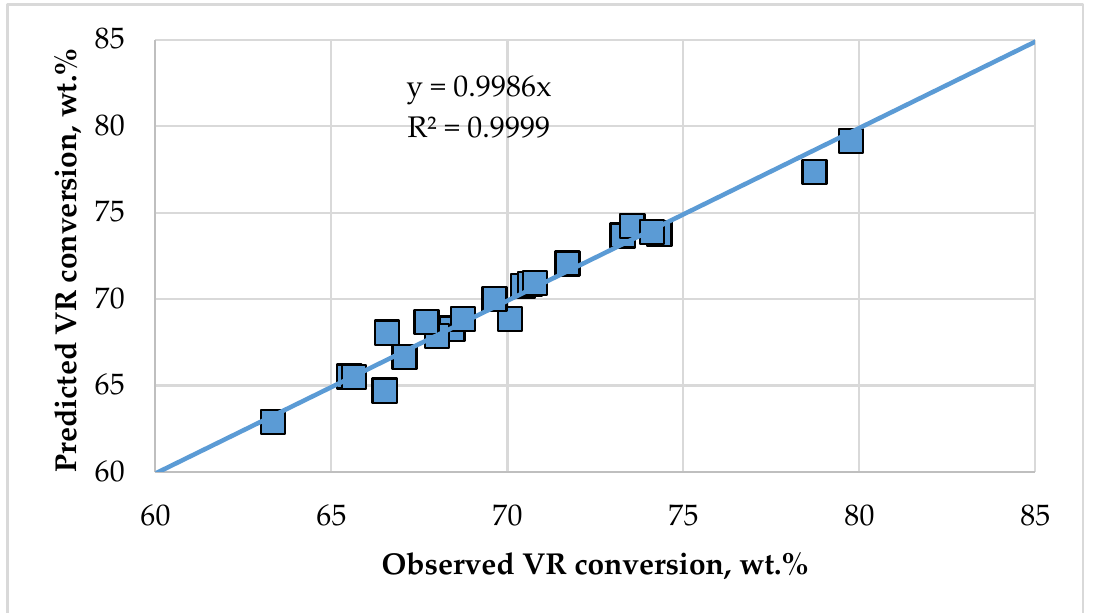
Figure 23. Agreement between observed and predicted by Equation (12) conversion of the straight- run vacuum residues having different SAR-AD fraction compositions.